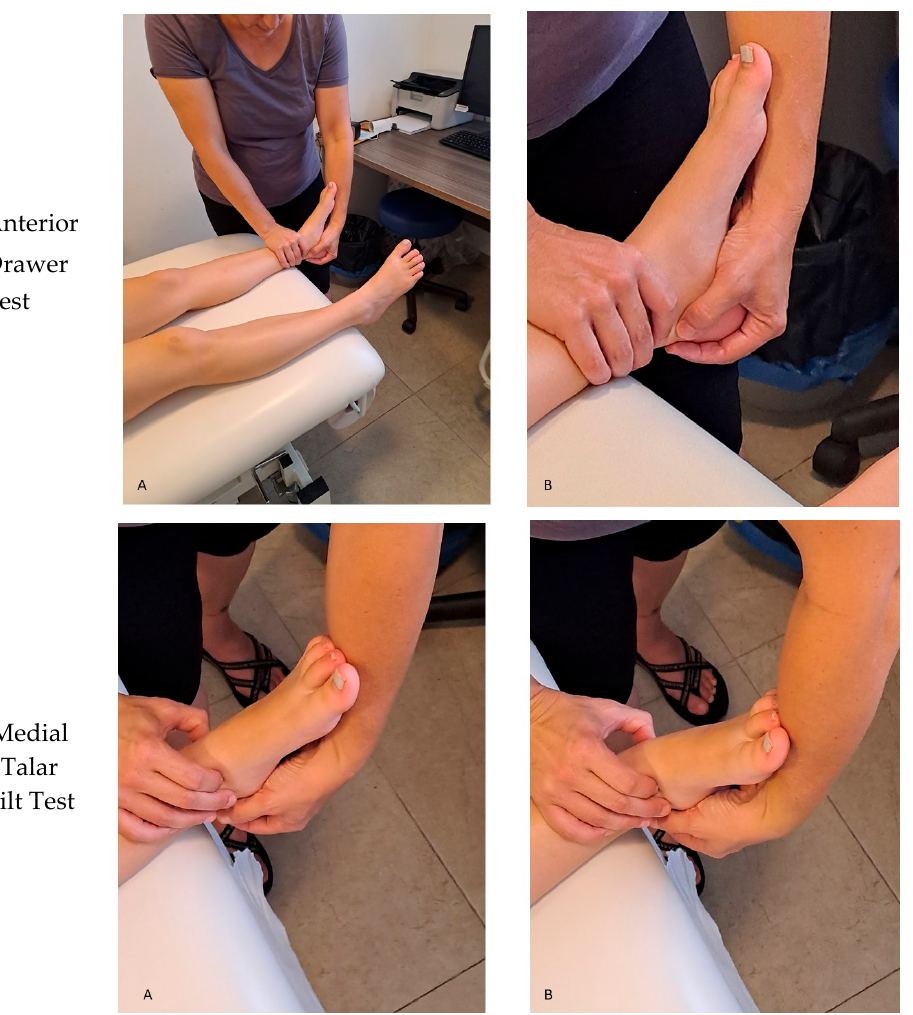
Figure 2. Anterior Drawer Test ( A : hand position B : drawing the talus and calcaneus anteriorly) and Medial Talar Tilt Test ( A : hand position B : talar tilt action).